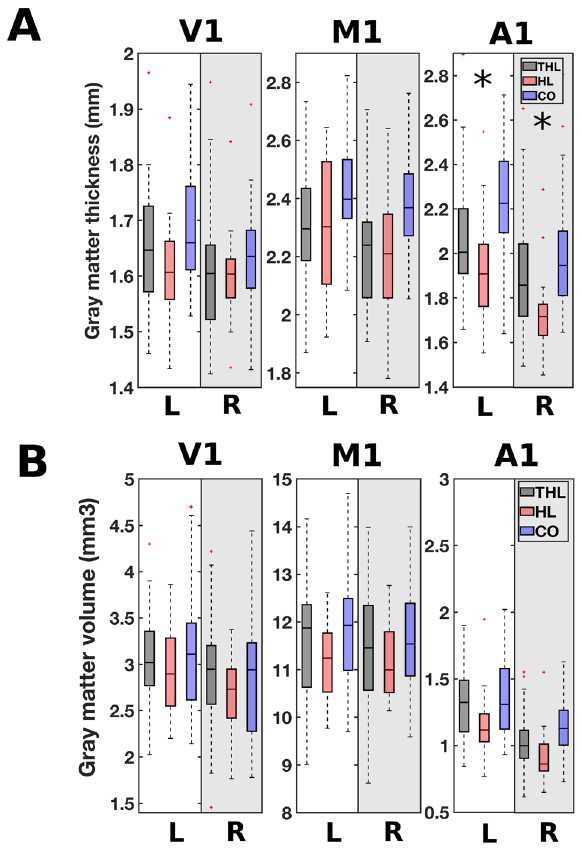
Figure 6. Cortical surface thickness (A) and gray matter volume (B) in primary visual cortex (V1), primary motor cortex (M1) and primary auditory cortex (A1) for the three participant groups: THL (hearing loss with tinnitus); HL (hearing loss without tinnitus); CO (controls without tinnitus or hearing loss). The boxplots show the cortical surface thickness and the gray matter volume for both the left (L) and right (R) hemispheres. Significance, corrected for multiple comparisons at a stringent Bonferroni level, is indicated with an asterisk.